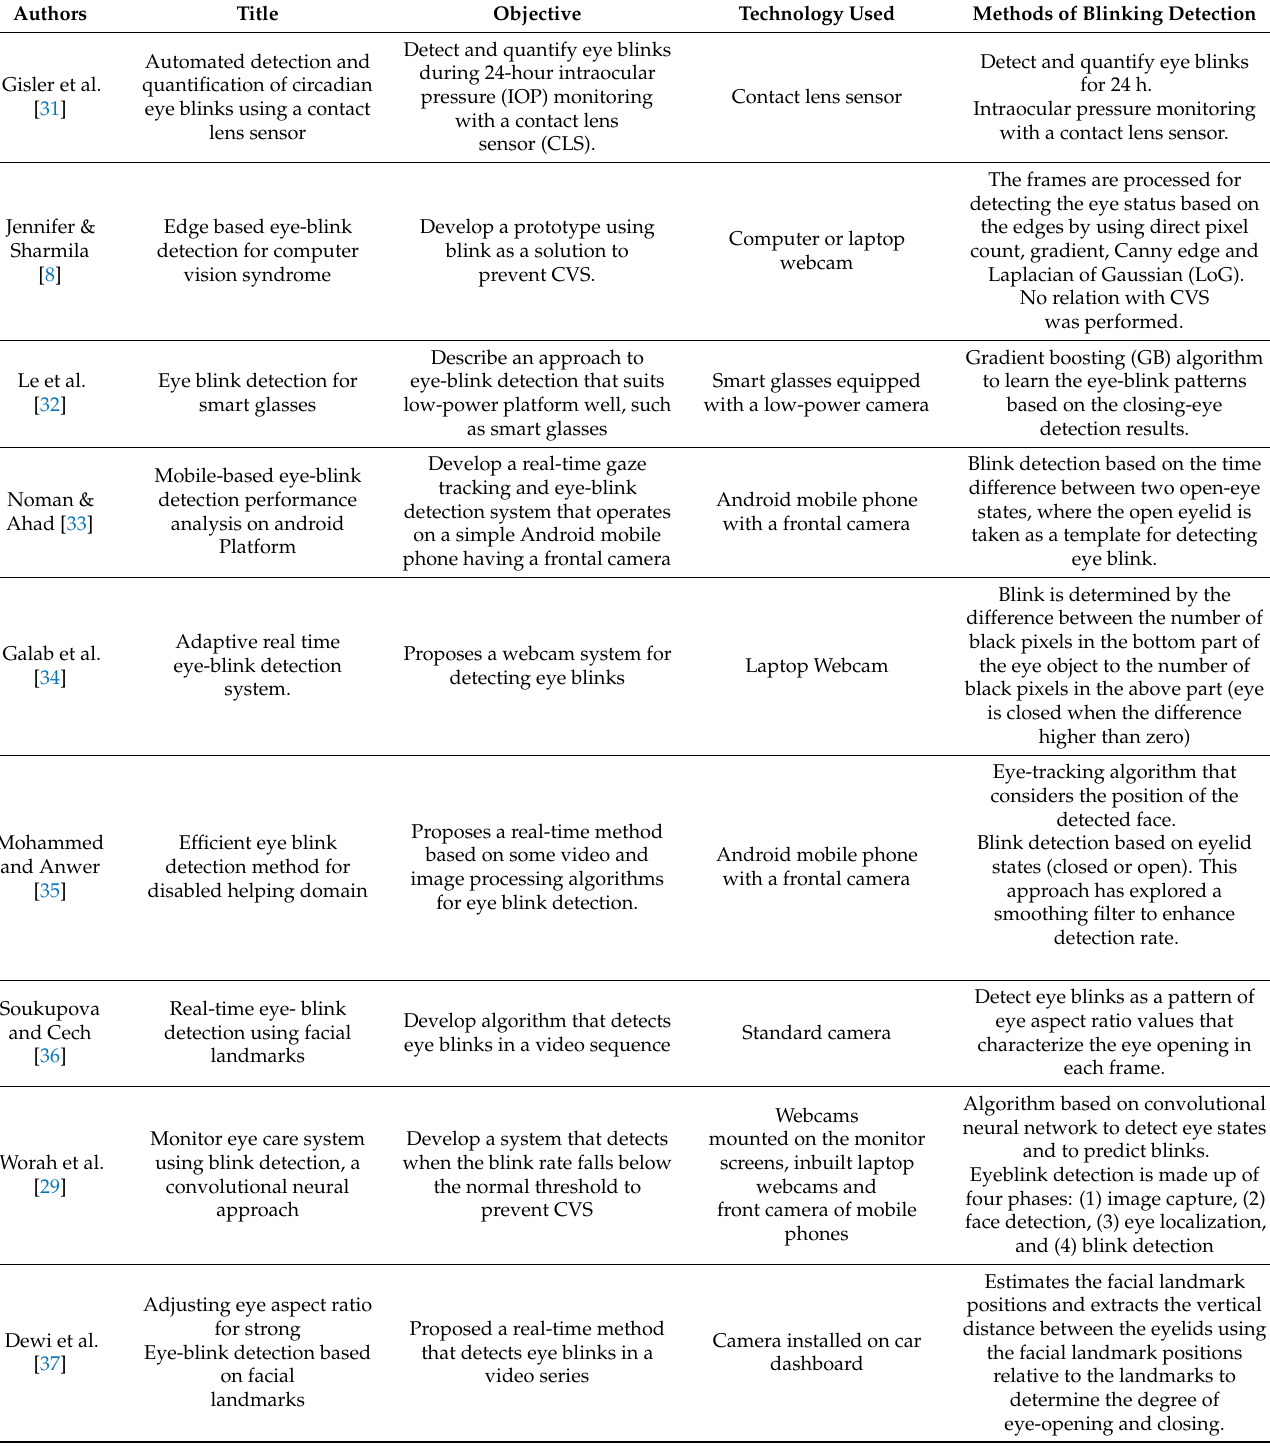
Algorithm based on convolutional neural network to detect eye states and to predict blinks. Eyeblink detection is made up of four phases: (1) image capture, (2) face detection, (3) eye localization, and (4) blink